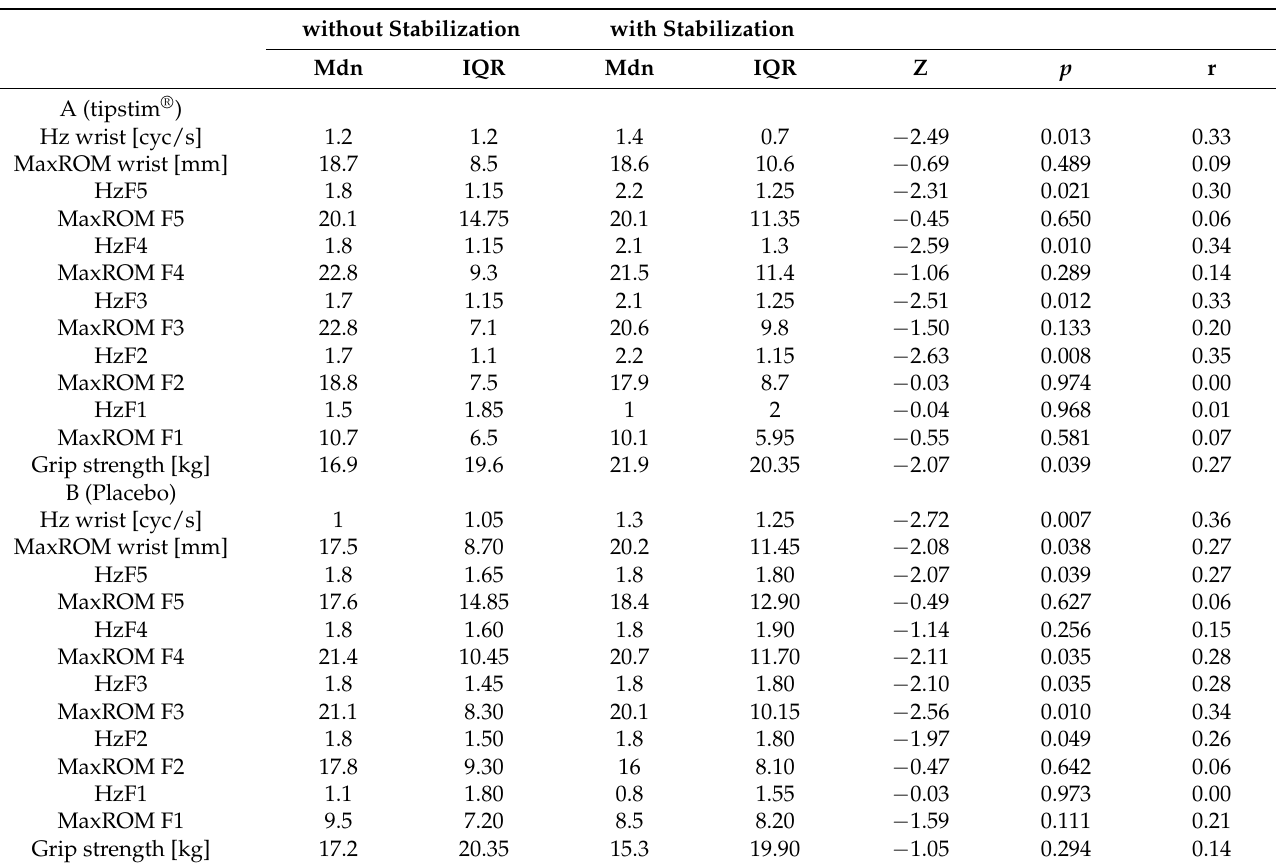
Table 7. Comparison of groups in terms of differences in parameters measured in the unstable and stable positions. without Stabilization with Stabilization